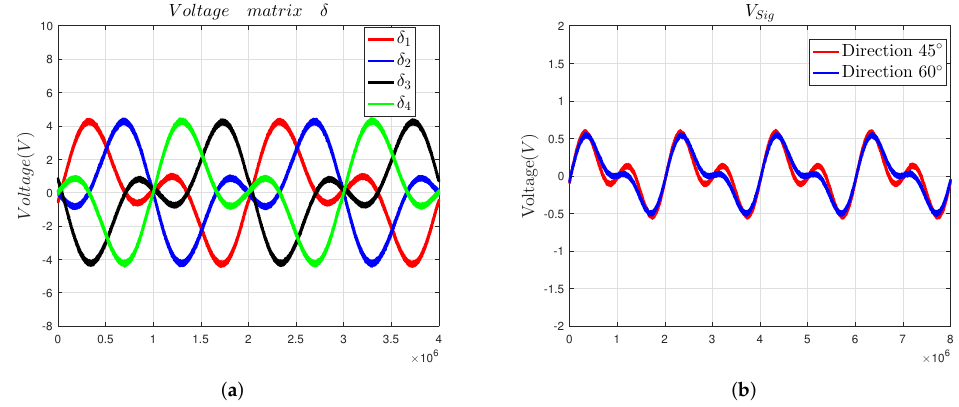
Figure 9. The actual waveform of the signal process circuit: ( a ) the voltage matrix δ and ( b ) the voltage signal V sig